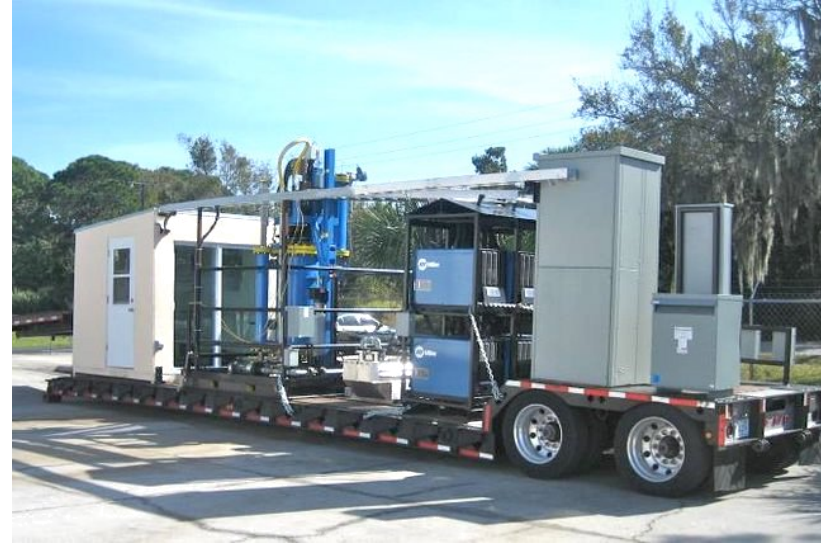
Figure 25: A picture of the 300 kW mobile magnegas refinery built by Santilli when Chief Scientist of Magnegas Corporation (now Taronis Corporation) to process a mixture of fossil oil and water into magnegas whose combustion with the proper stochiometric oxygen has no detectable CO or HC [57]. The oxygen content of magnegas appears to have special polarizations [62] - [65] deserving tests for its possible use in ventilators to kill Corona viruses due to the emission of strong UV light in its depolarization in human